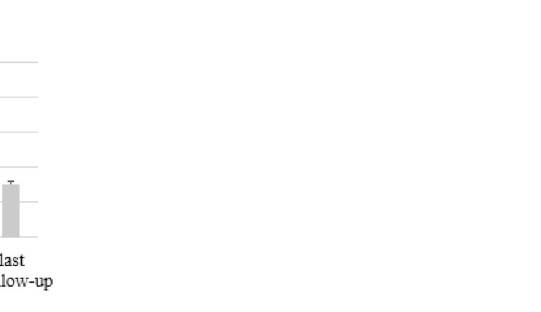
Figure 4. Histograms for ODI scores (* P < 0.05, comparation between the two groups).